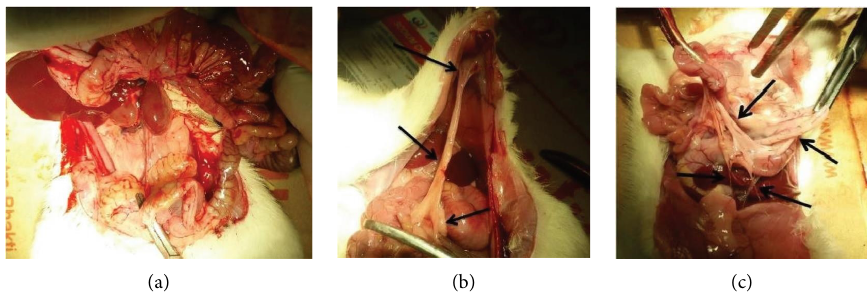
Figure 5: (a) No adhesion, (b) thin adhesion, (c) thick